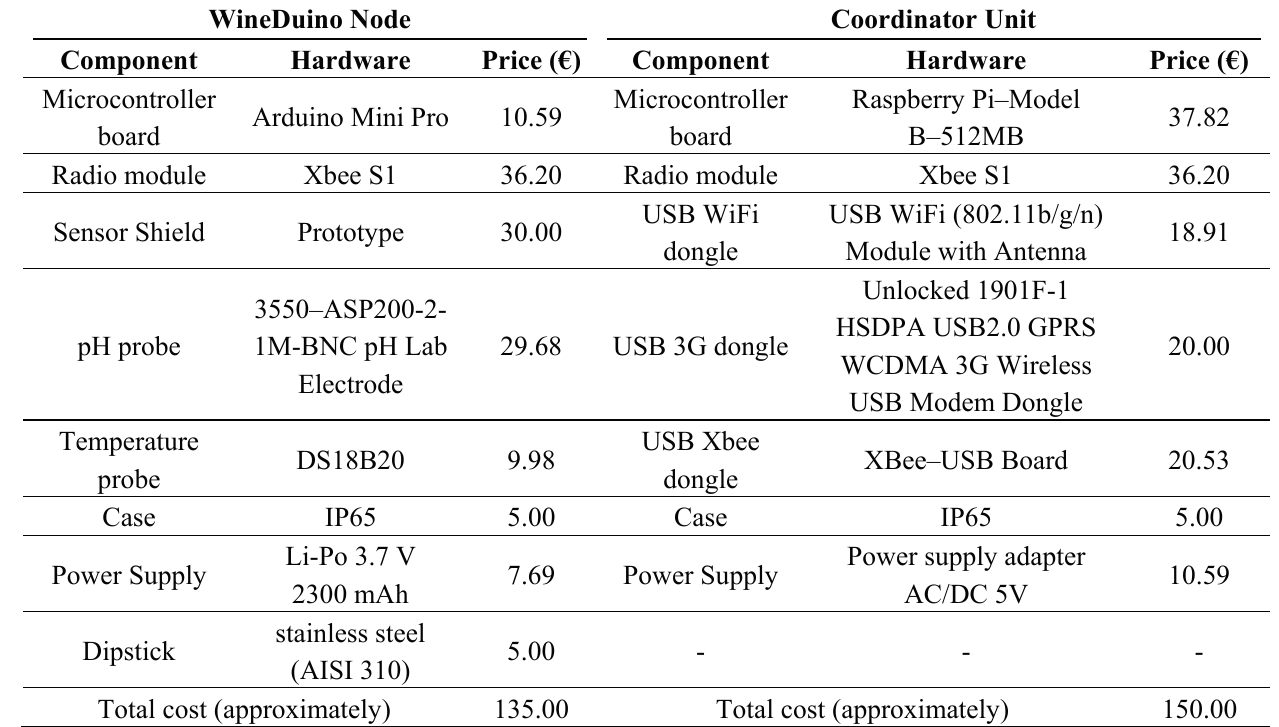
Table 1. WineDuino system cost